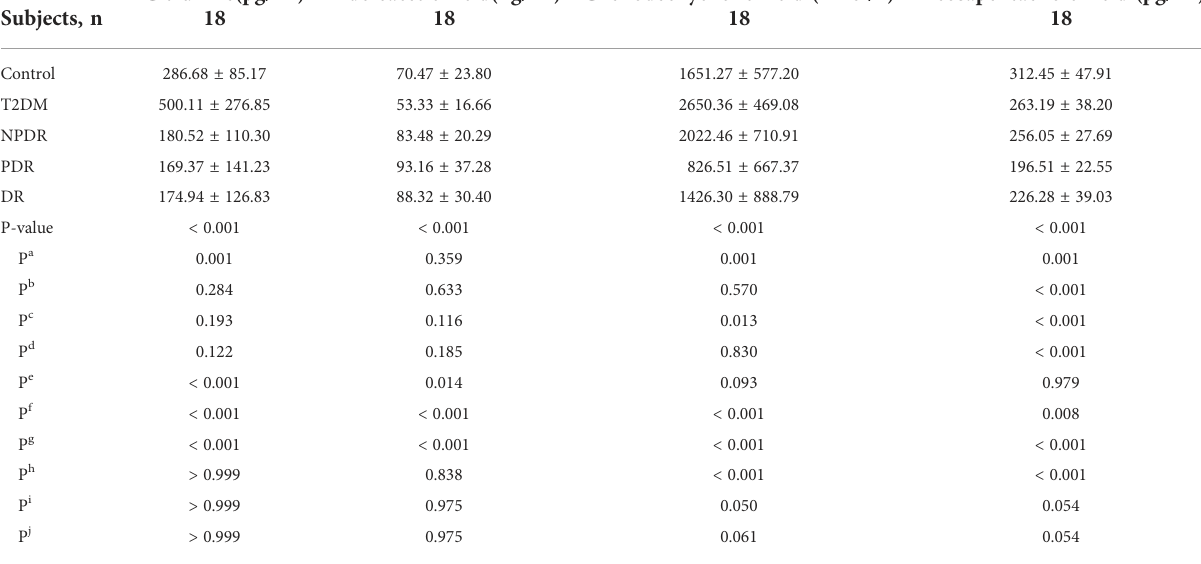
TABLE 3 Validate the Differential Metabolites in control, T2DM, NPDR, PDR and DR groups by ELISA. L-Citrulline(pg/ml) Indoleacetic Acid(ng/ml) Chenodeoxycholic Acid (nmol/L) Eicosapentaenoic Acid (pg/ml) Subjects,